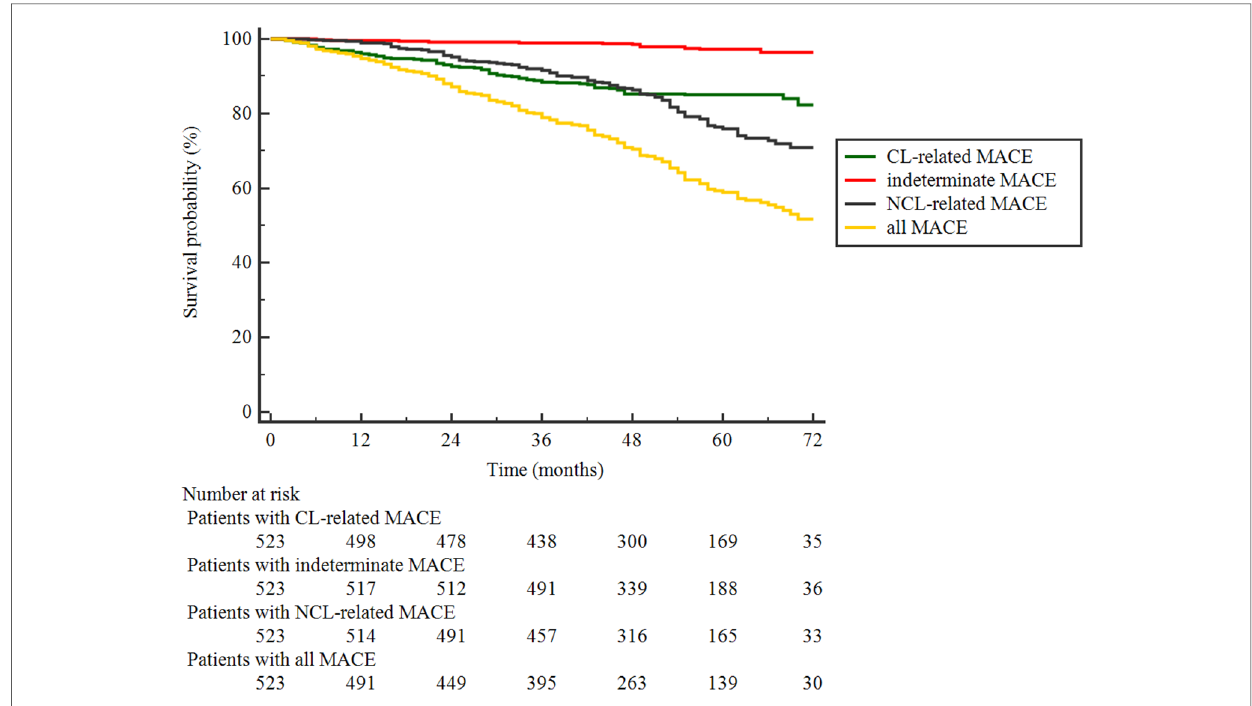
FIGURE 2 Kaplan – Meier curves of patients surviving event-free from the fi rst MACE of each classi fi cation and